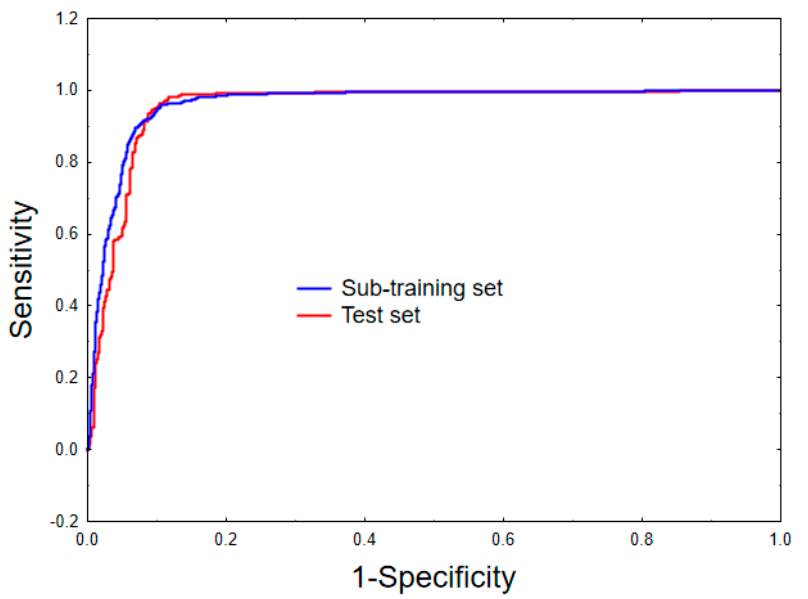
Figure 2. Receiver operating characteristic curves for the sub-training (ten-fold cross-validation) and the test sets.